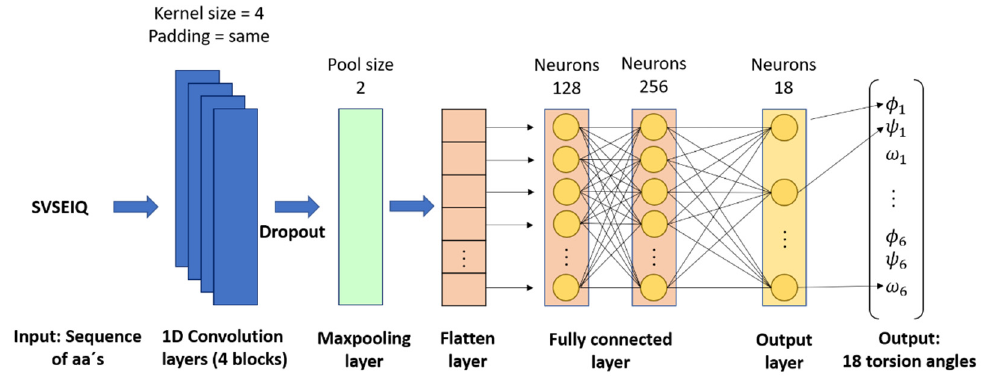
Figure 2. FCNN Architecture.